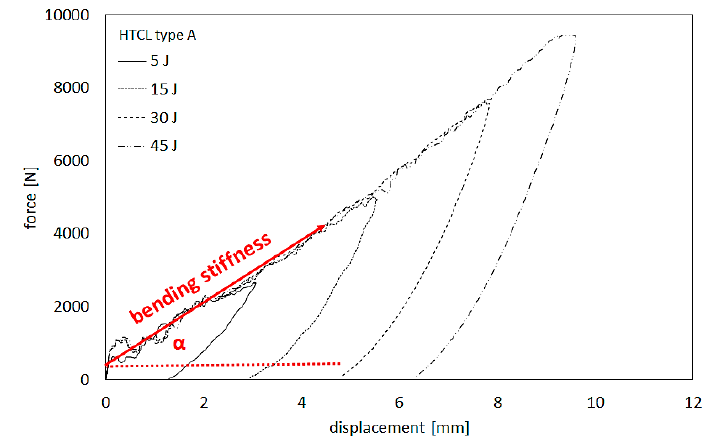
Figure 7. An example of force–displacement curves after impact with a visualization of bending stiffness.